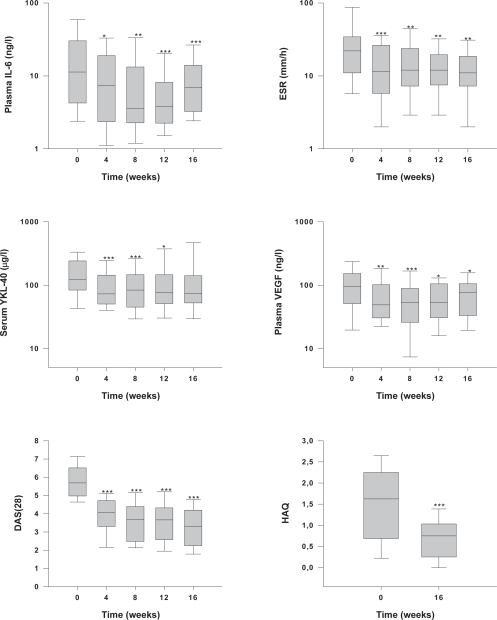
The changes in plasma IL-6, plasma VEGF, serum YKL-40, ESR and DAS28(ESR) in 25 RA patients during the 16-week study period, divided by being EULAR good/moderate responders or EULAR non-responders. Values are given as box and whiskers plots. Boxes indicate 25th, 50th, 75th centiles. Whiskers indicate 5th–95th percentiles. The y-axis is logarithmic for the biomarkers. *, ** and *** indicate statistically significant changes from baseline (Wilcoxon-Pratt): *p < 0.05, **p < 0.01, ***p < 0.001.